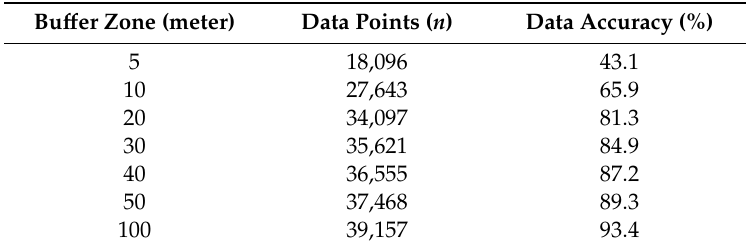
Table 1. Bu ff er Zone